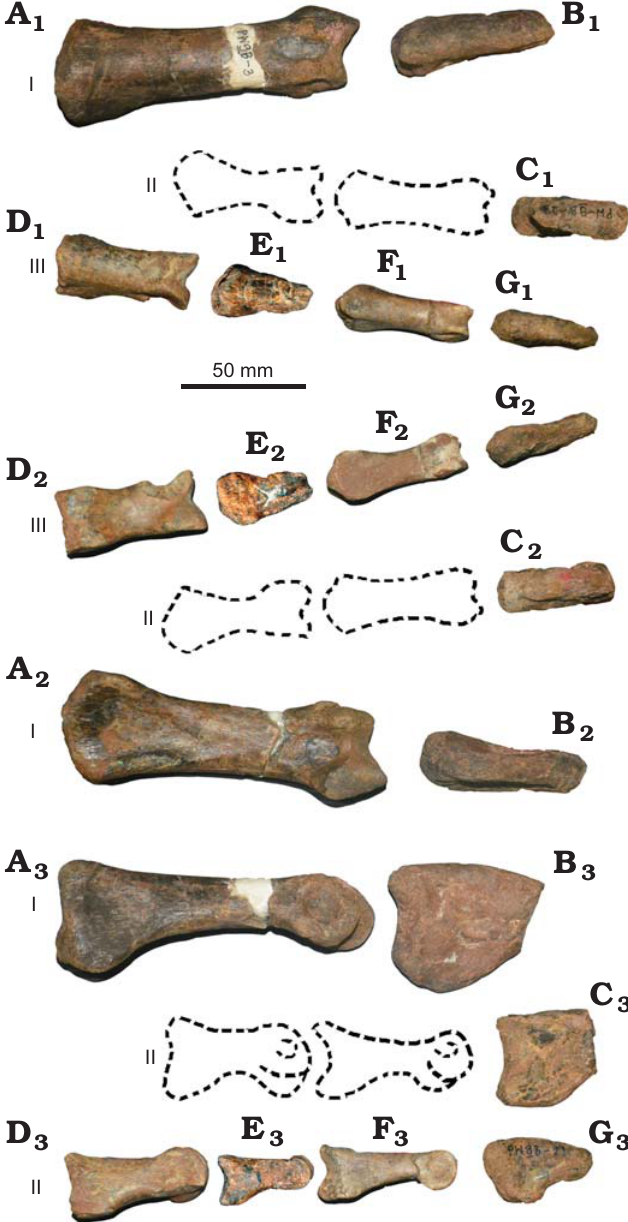
Fig. 6. Coelurosaurian theropod Phuwiangvenator yaemniyomi gen. et sp. nov. from the Early Cretaceous Sao Khua Formation of Phu Wiang, Khon Kaen Province, Thailand. SM-PW9B-3 ( A ), SM-PW9B-19 ( B ), SM- PW9B-23 ( C ), SM-PW9B-4 ( D ), SM-PW9B-7 ( E ), SM-PW9B-5 ( F ), SM- PW9B-21 ( G ); manual phalanges I–III (A, D, E, F) and unguals I–III (B, C, G), in dorsal (A 1 –G 1 ), ventral (A 2 –G 2 ), and lateral (A 3 –G 3 ) views. Dashed lines are the reconstruction of manual phalanges II-1 and into two distinct condyles. The distal surface of the medial condyle is larger than the lateral condyle, as in Kileskus and Australovenator (White et al. 2012). The medial condyle protrudes slightly more distally than the lateral condyle. The pits for the collateral ligaments are not well developed on both condyles. There is no distinct extensor pit on the anterior surface of the shaft proximal to the distal condyle, only a small concavity is present.